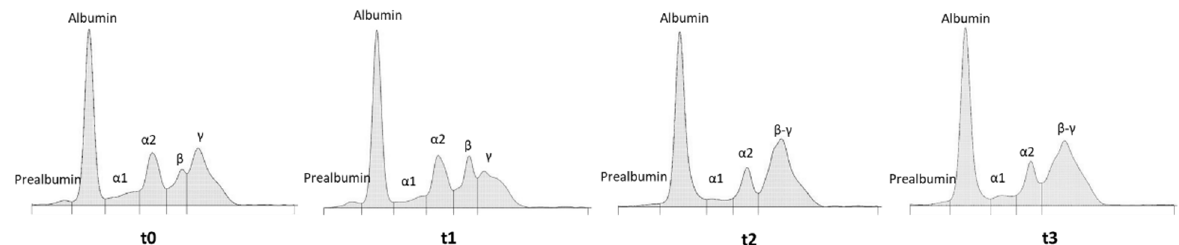
Figure 1. Representative electropherograms of serum proteins using agarose gel electrophoresis (AGE) obtained from the same control hen at different experimental time points: t0, start of the trial; t1 (5th week), before the start of laying; t2 (12th week), end of the supplementation; and t3 (19th week), end of the trial.